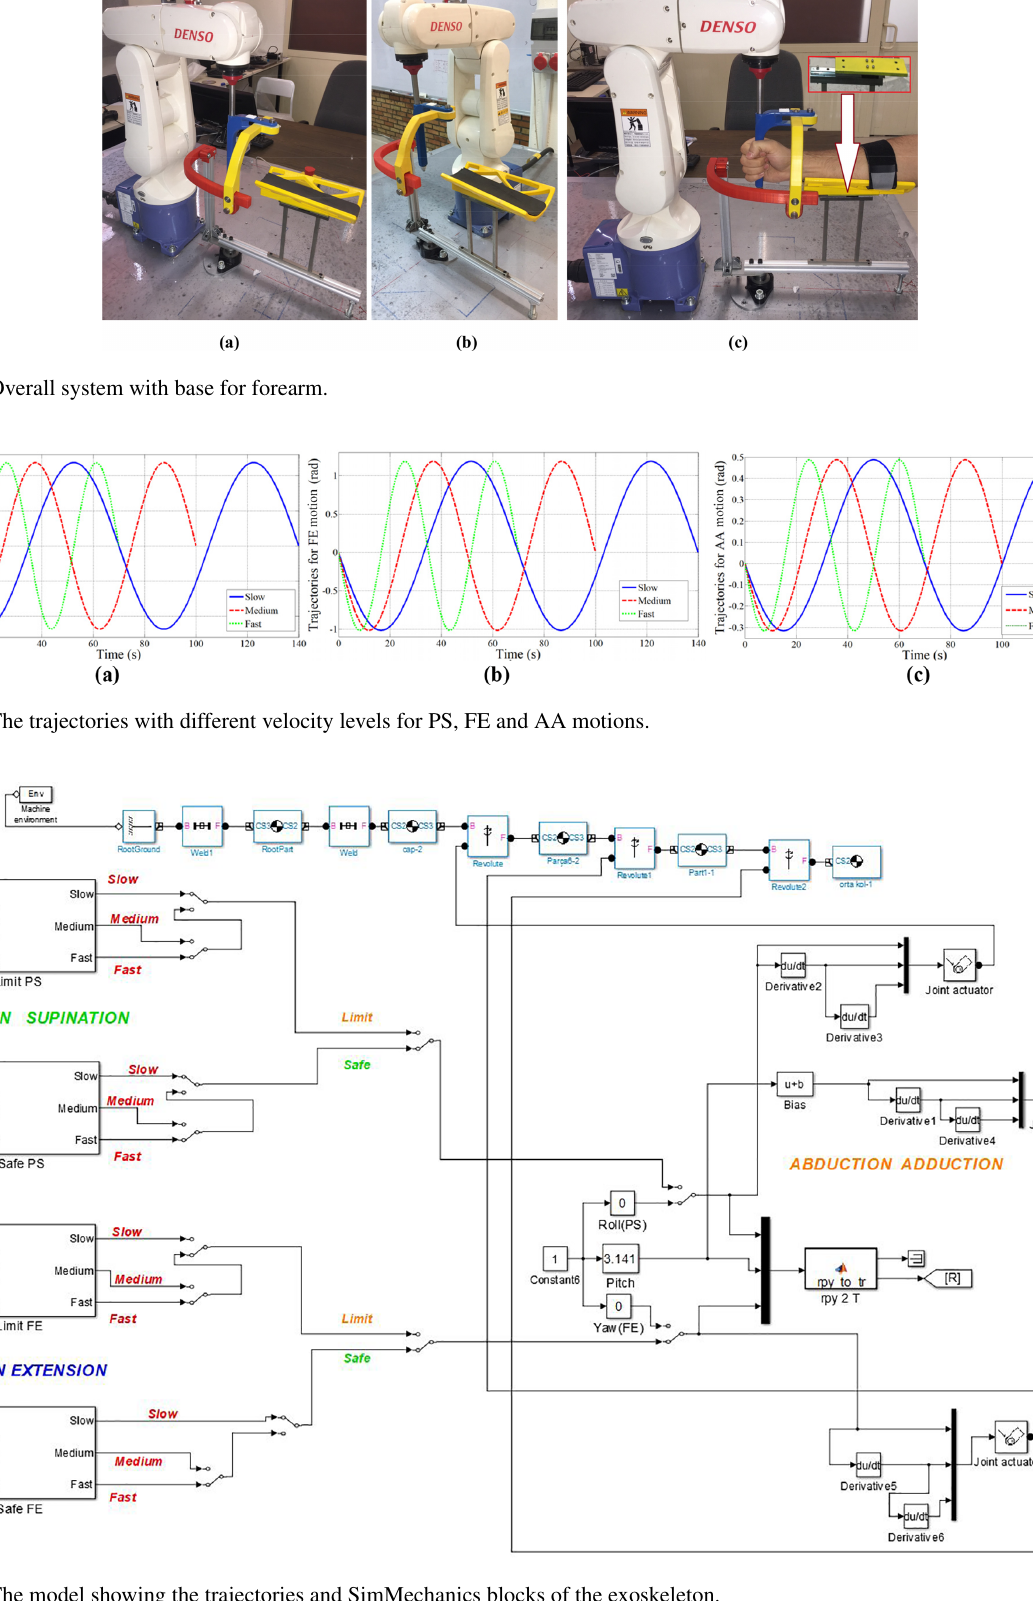
Mech. Sci., 10, 107–118, 2019